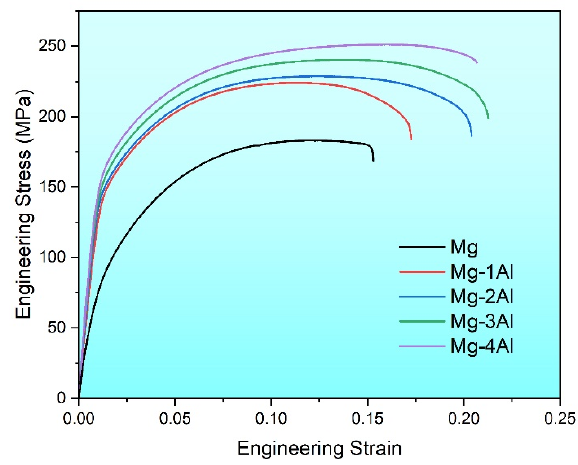
Figure 5. Tensile stress–strain curves of the as-extruded Mg–xAl (x = 0, 1, 2, 3, 4) alloys. The EBSD results (inverse pole figure (IPF) maps) obtained from the cross section of the alloy are shown in Figure 6. It is shown that grains of Mg and Mg–Al alloy have the similar orientation by the color distribution in IPF maps. In these system alloys, green zone illustrated that the grain is orientated with (1010) plane and blue zone represents (1120) plane. That is to say, the as-extruded samples present a basal texture that the basal planes of most grains parallel to the extrusion direction. Still, small variation goes forward along with the concentration, the region of green and blue trends to narrow down slightly, which illustrates that the addition of Al modifies the grain orientation in Mg–Al alloy and weaken the texture.